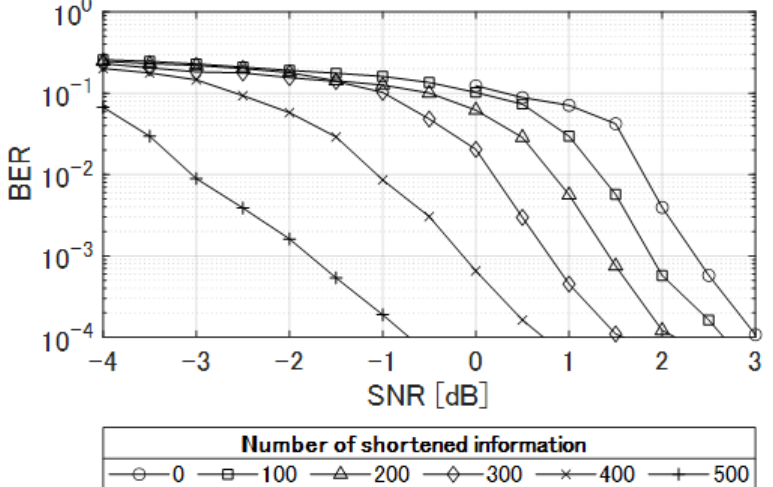
Figure 7. Bit error ratio (BER) characteristics of the receiver whose shortened information is known under the additive white Gaussian noise (AWGN) channel. The shortened information length m using distance information is varied from 0 to 500.